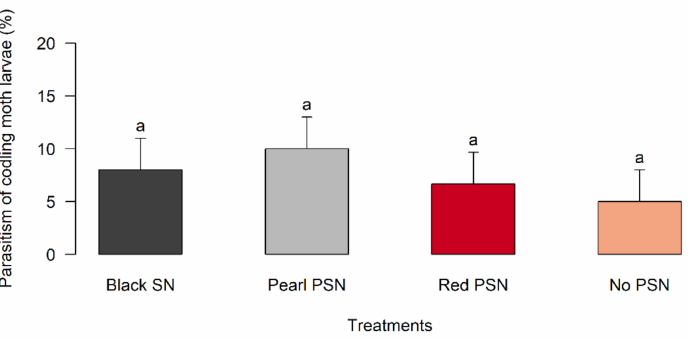
Figure 2. Effects of the PSN and black SN on the parasitism (%) (mean ± SE, n = 15) of M. ridens on fifth-instar C. pomonella larvae. The same letters above bars and SE indicate no significant differences among treatments according to the Kruskal–Wallis